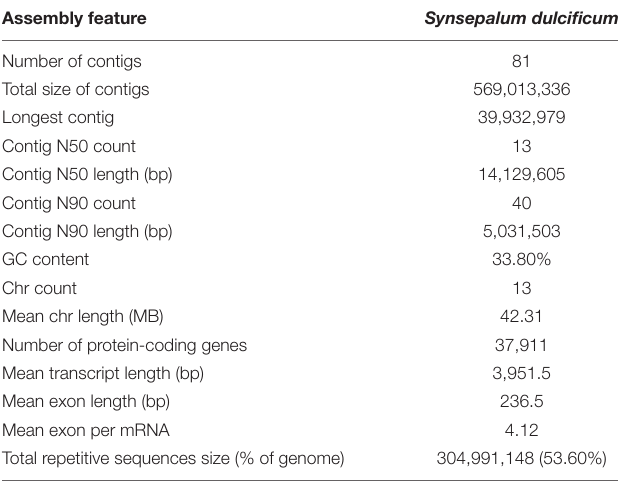
and Supplementary Table 6 ). GO and KEGG enrichment TABLE 1 | Statistics of S. dulcificum genome assembly and